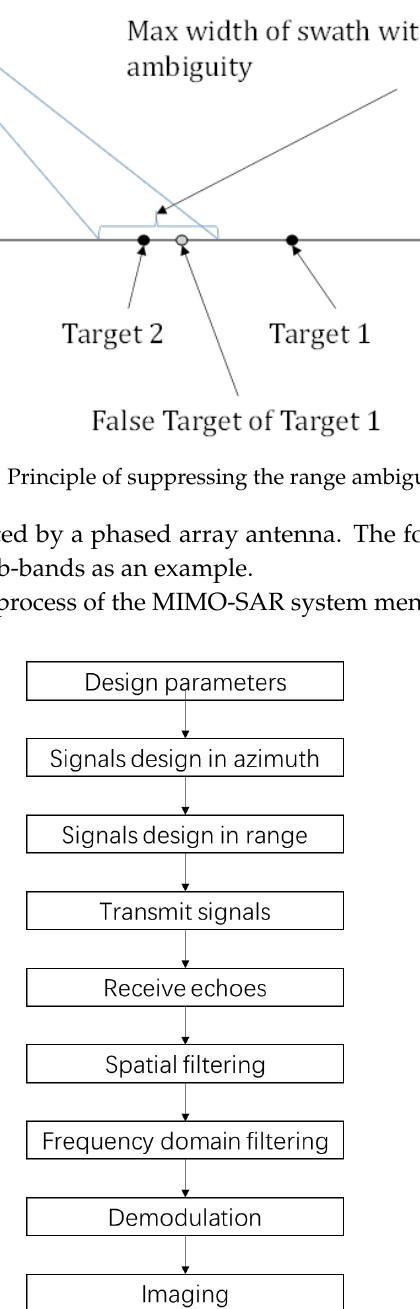
Figure 7. Diagram of the MIMO-SAR system designed in this paper.